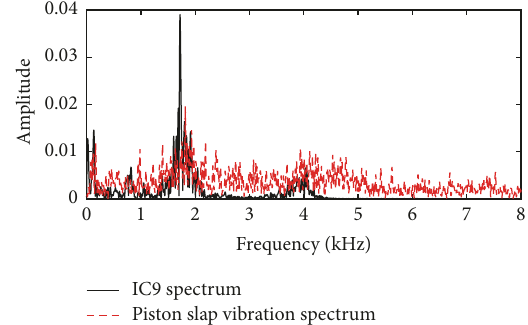
Figure 17: FFT of IC9 and piston slap vibration.